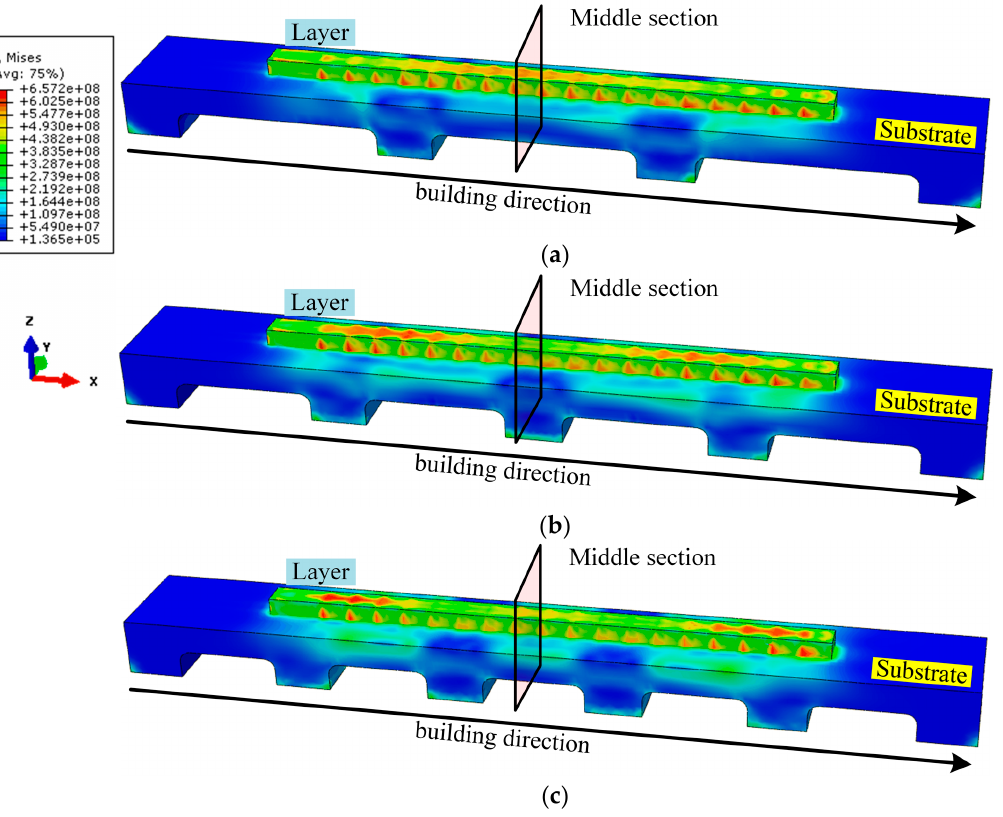
Figure 12. Residual von Mises stresses with different numbers of support legs: ( a ) 4 legs; ( b ) 5 legs; ( c ) 6 legs.